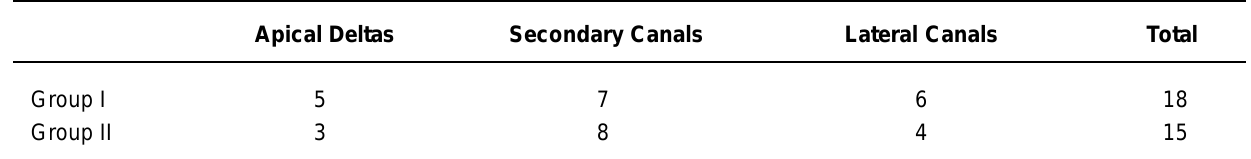
TABLE 1- Presence of apical deltas, lateral canals and secondary canals for different irrigation regimens